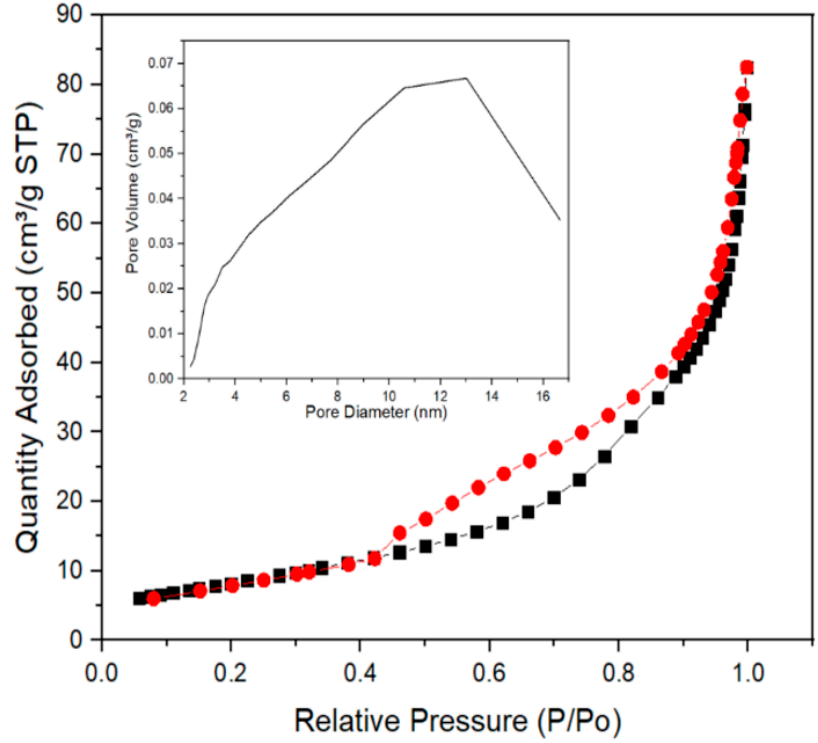
Figure 5. Adsorption–desorption isotherms of N 2 .